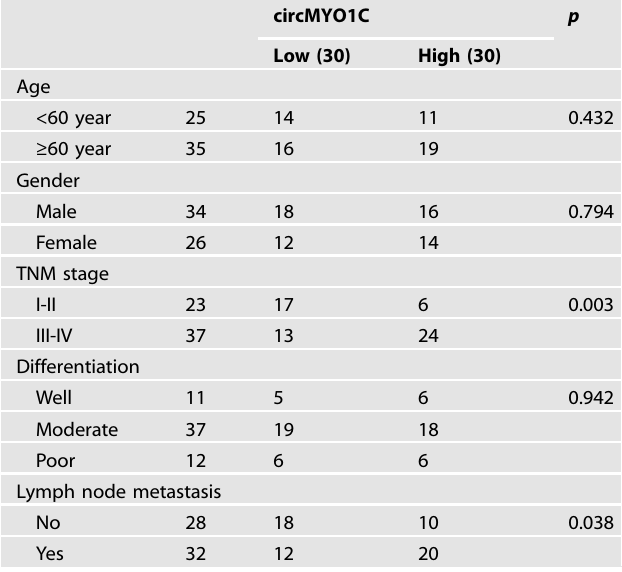
Table 1. The correlations between circMYO1C levels and PDAC patients ’ clinicopathological